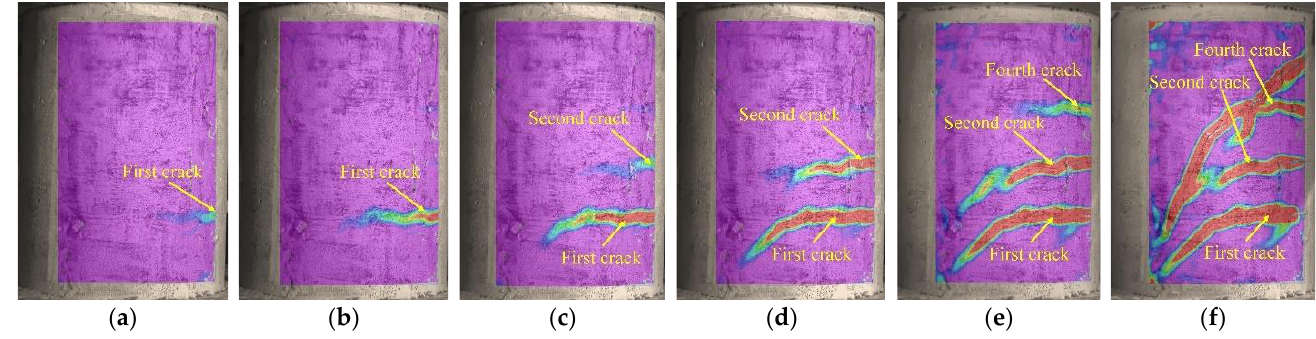
Figure 21. Principal strain nephograms of test specimen S1. ( a ) 27 kN; ( b ) 40 kN; ( c ) 50 kN; ( d ) 65 kN; ( e ) 80 kN; ( f ) 95 kN.